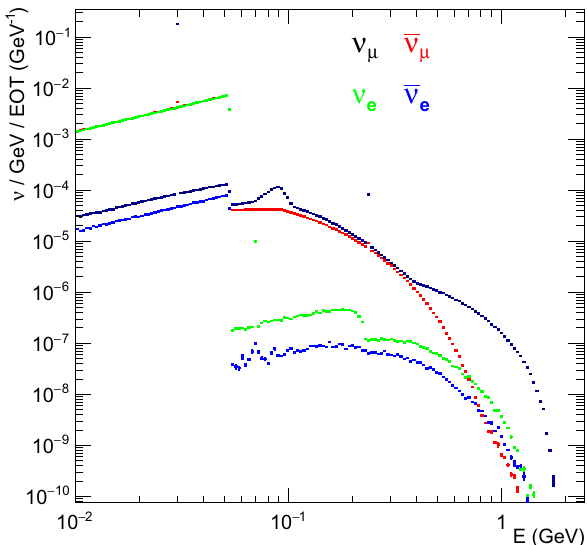
Fig. 9 Neutrino differential flux, per EOT, of neutrinos produced by theinteractionoftheCEBAF2.176GeV e − beamwiththeHall-Abeam dump. The flux is scored on a plane located 0.5 m upstream the BDX- MINI detector. Each color correspond to a different neutrino topology, as reported in the Figure. The discontinuity at (cid:3) 50 MeV is due to the muon at-rest decay process, μ → e